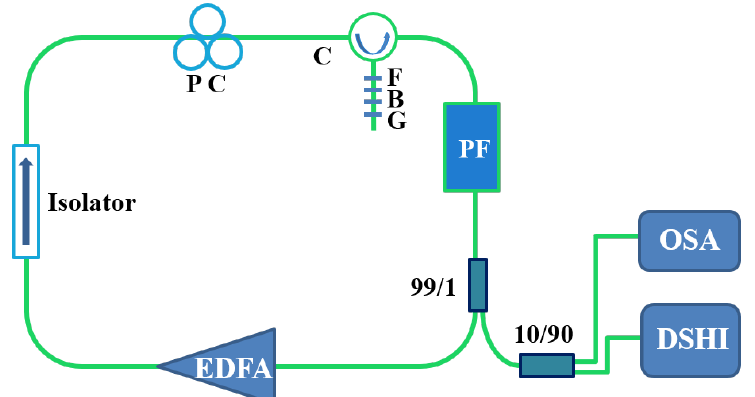
Figure 3. The diagram of the ring laser. Abbreviations: PC, polarization controller; C, optical circulator; FBG, fiber Bragg grating; PF, polarization filter shown as the inset, which has been introduced above; FB, fiber bench; PBS, polarization beam splitter; EDFA, erbium-doped fiber amplifier; isolator, optical isolator; 99/1 and 10/90, optical couplers and their ratios; OSA, optical spectrum analyzer; and DSHI, delayed self-heterodyne interferometer device.